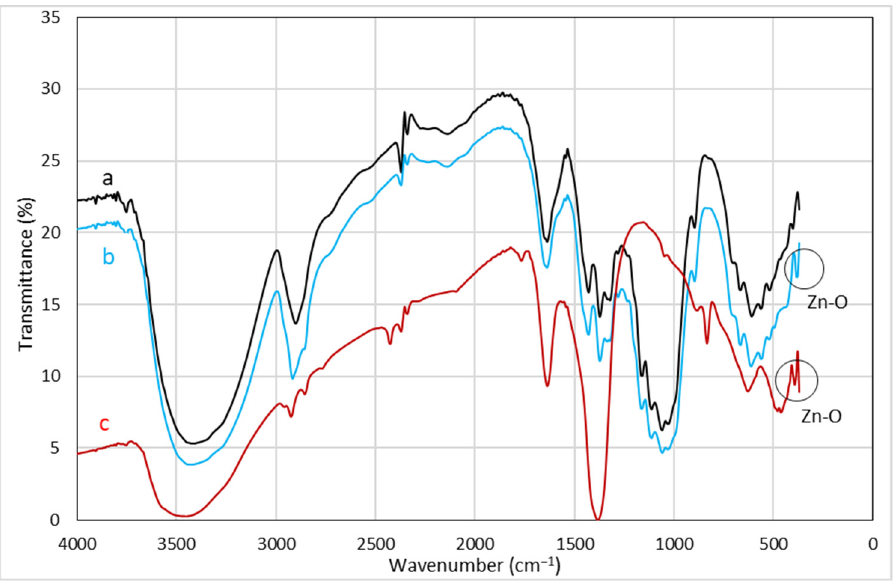
Figure 5. FT-IR spectra of (a) untreated fabric, (b) ZnO NPs-treated ND-colored Batik fabric, (c) ZnO NPs powder.